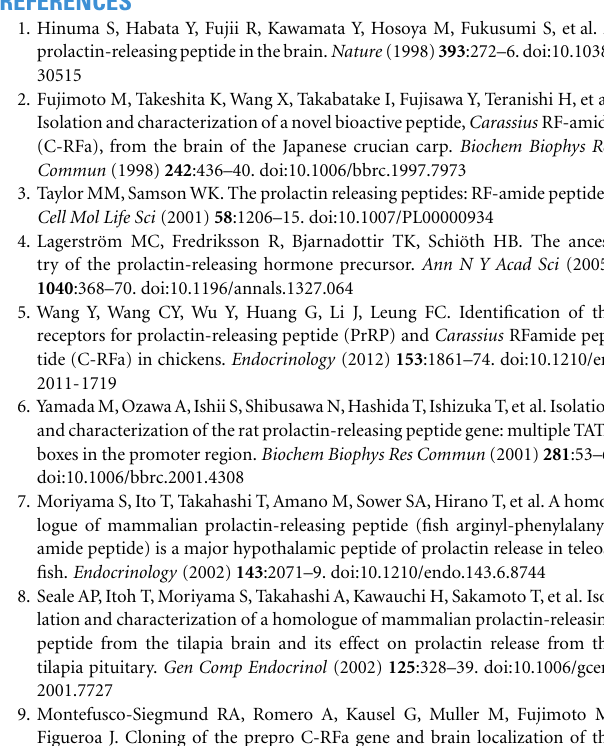
Figueroa J. Cloning of the prepro C-RFa gene and brain localization of